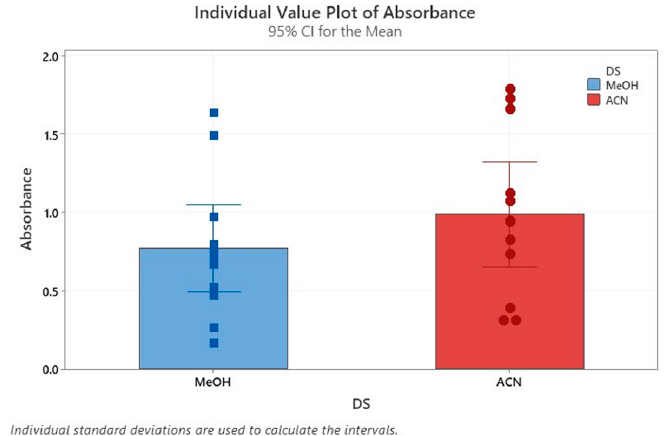
Figure 4. Individual value plots for the measured absorbance of the colored CTC with added interval bars at 95.0% CI.